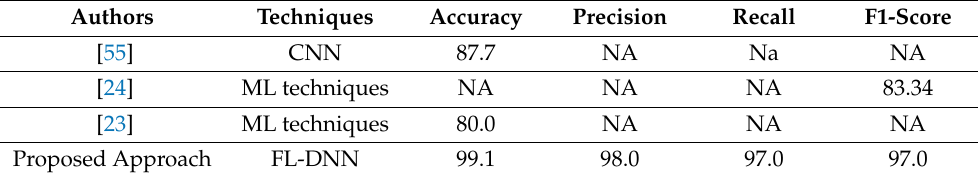
Table 7. Comparison with previous